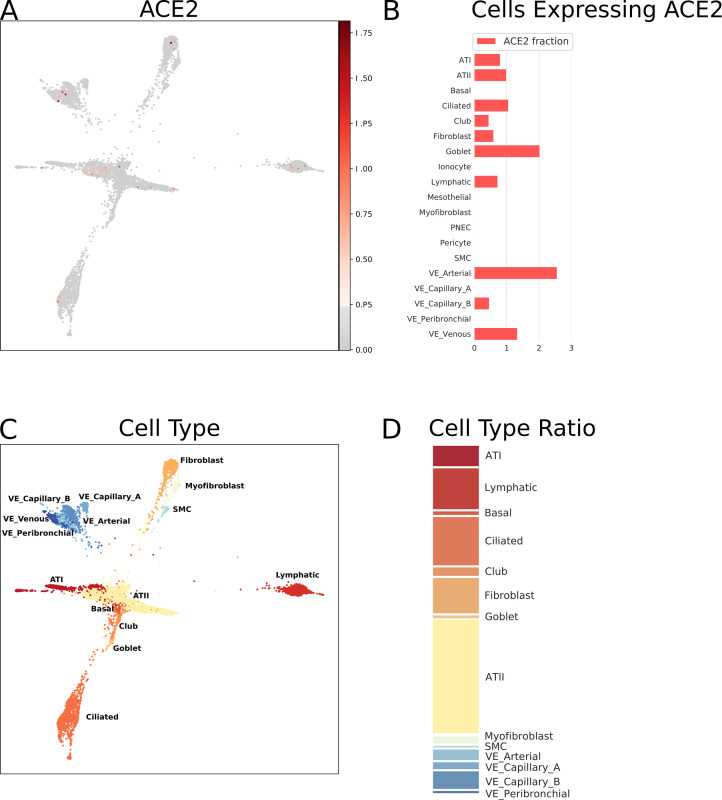
Single cell RNA-Seq analysis of different cell types from the lung (human), derived from data from GEO dataset GSE136831 [50].ACE2 mRNA expression as normalized, batch-corrected counts is shown for comparison in upper panel. The force directed layout plot was computed and visualized in ScanPy [54]. For each cell type the ratio of cells expressing ACE2 is presented in addition to a stacked barplot of the relative cell type frequencies in the whole dataset. Alveolar type I (ATI), alveolar type II (ATII), pulmonary neuroendocrine cells (PNEC), smooth muscle cells (SMC), vascular endothelia (VE).